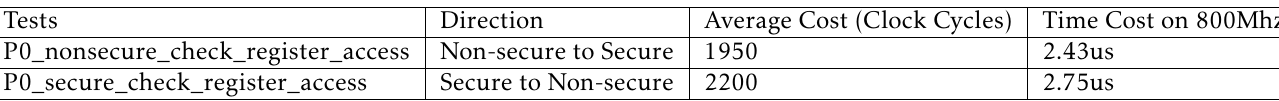
Table 2. TrustZone-related Instructions Cost on ARMv8 Cortex-A